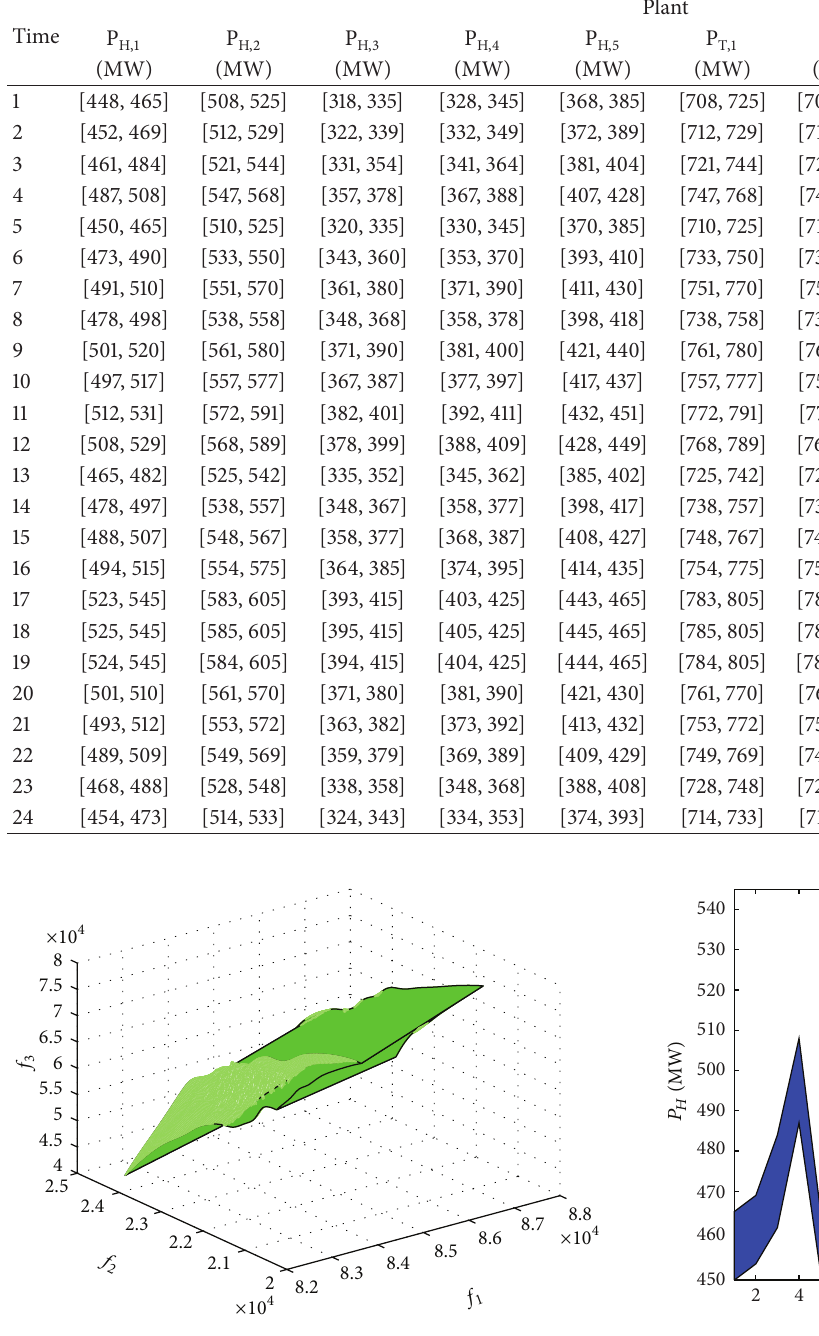
Figure 5: Pareto cube with three objects 𝑓 1 𝑓 2 and 𝑓 3 .